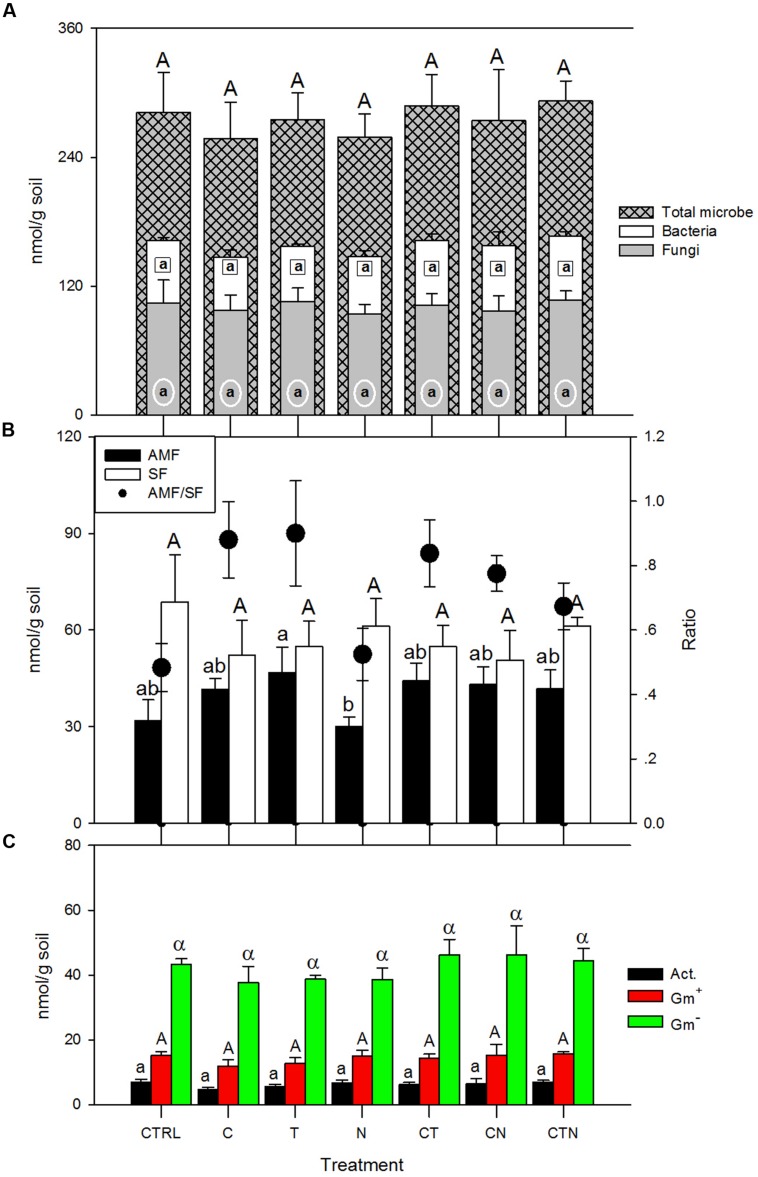
Lipid guild abundance (nmol/g soil) under single and combined global change treatments. Bars indicate SE of the mean (n = 4 or 5). Bars sharing the same letter are not significantly different (P = 0.05, LSD test). CTRL, control; C, elevated CO2; T, elevated temperature; N, nitrogen deposition; AMF, arbuscular mycorrhizal fungi; SF, saprotrophic fungi; Gm+, gram-positive bacteria; Gm-, gram-negative bacteria; Act., actinomycete.